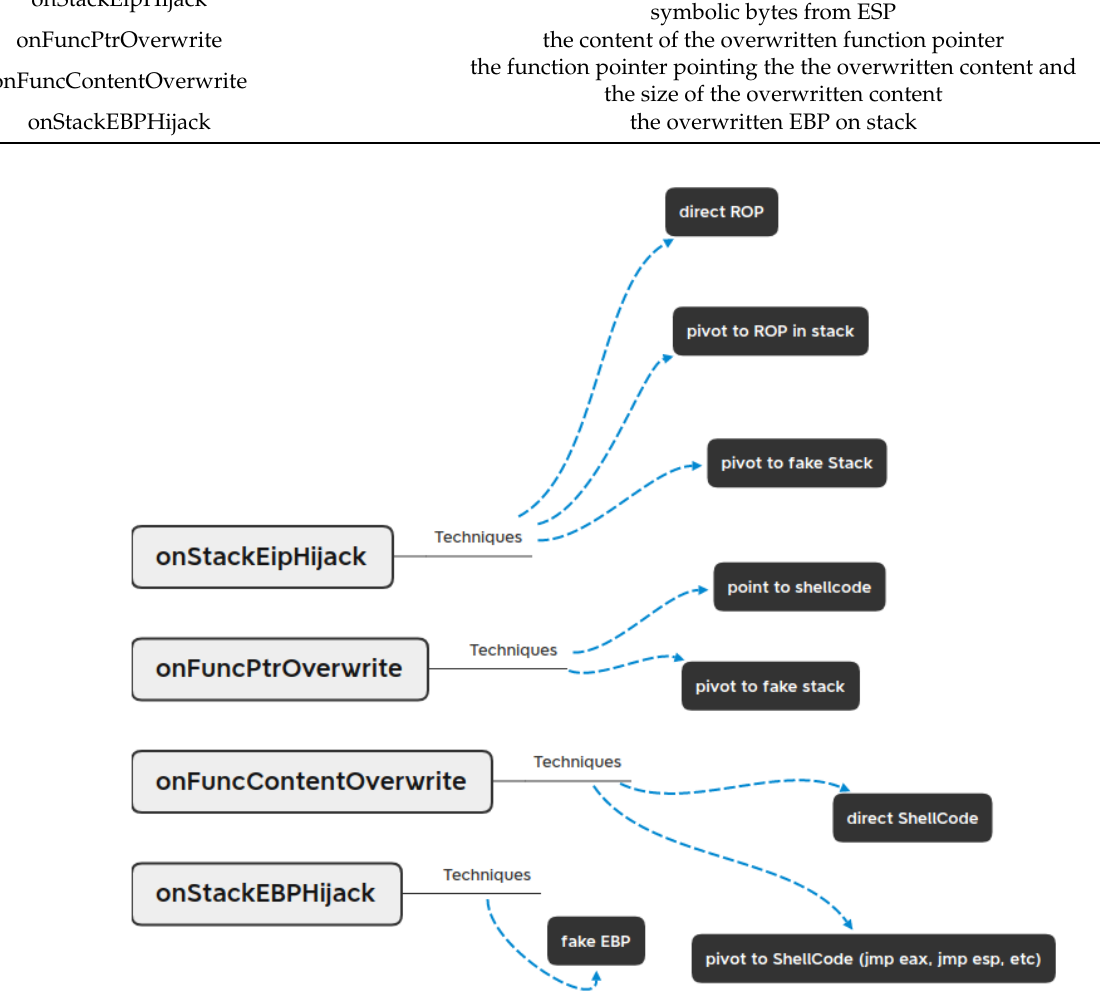
Figure 7. Bounds between Exploitable States and Exploitation